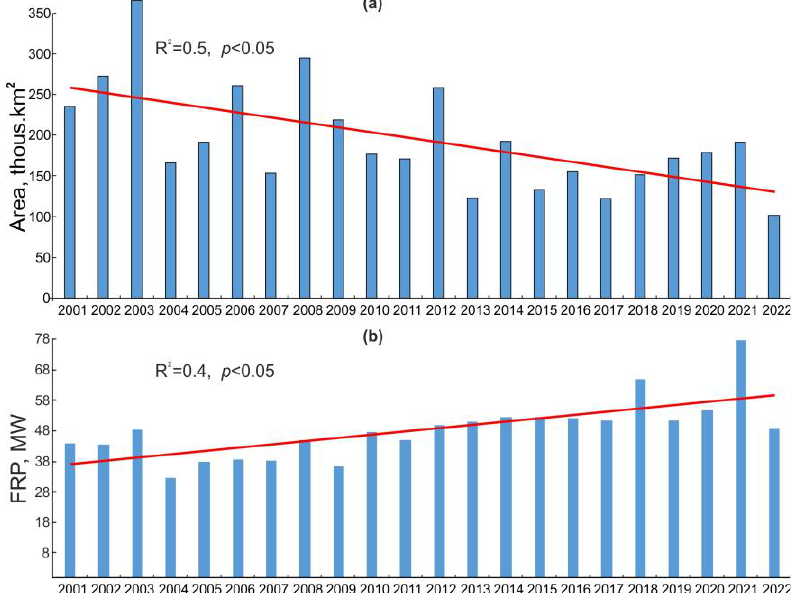
Figure 1. Results of satellite monitoring of wildfire hotspots in Russia from April to October 2001 – 2022: annual burned areas with a linear trend ( a ); average annual FRP with a linear trend ( b